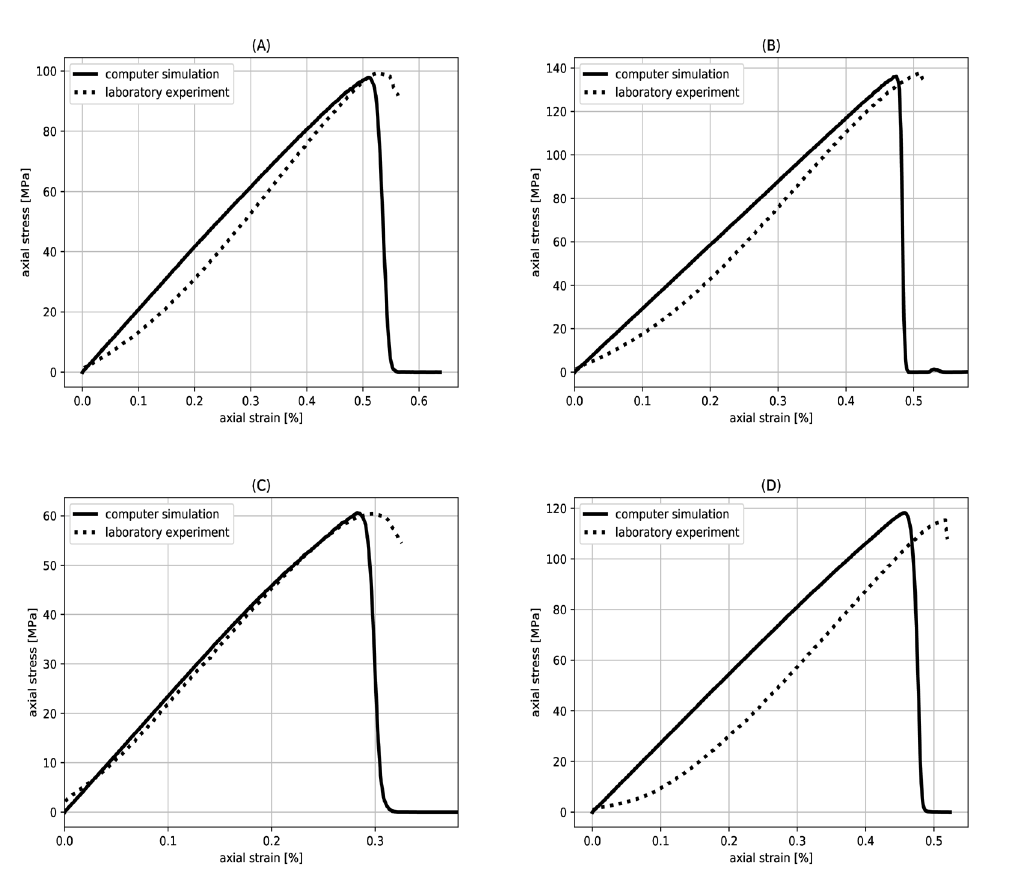
Figure 8: Comparison between numerical and laboratory stress-strain curves for selected samples: (A) Brenna BR2, (B) Mucharz MU1, (C) Radków RAD1 and (D) Tumlin